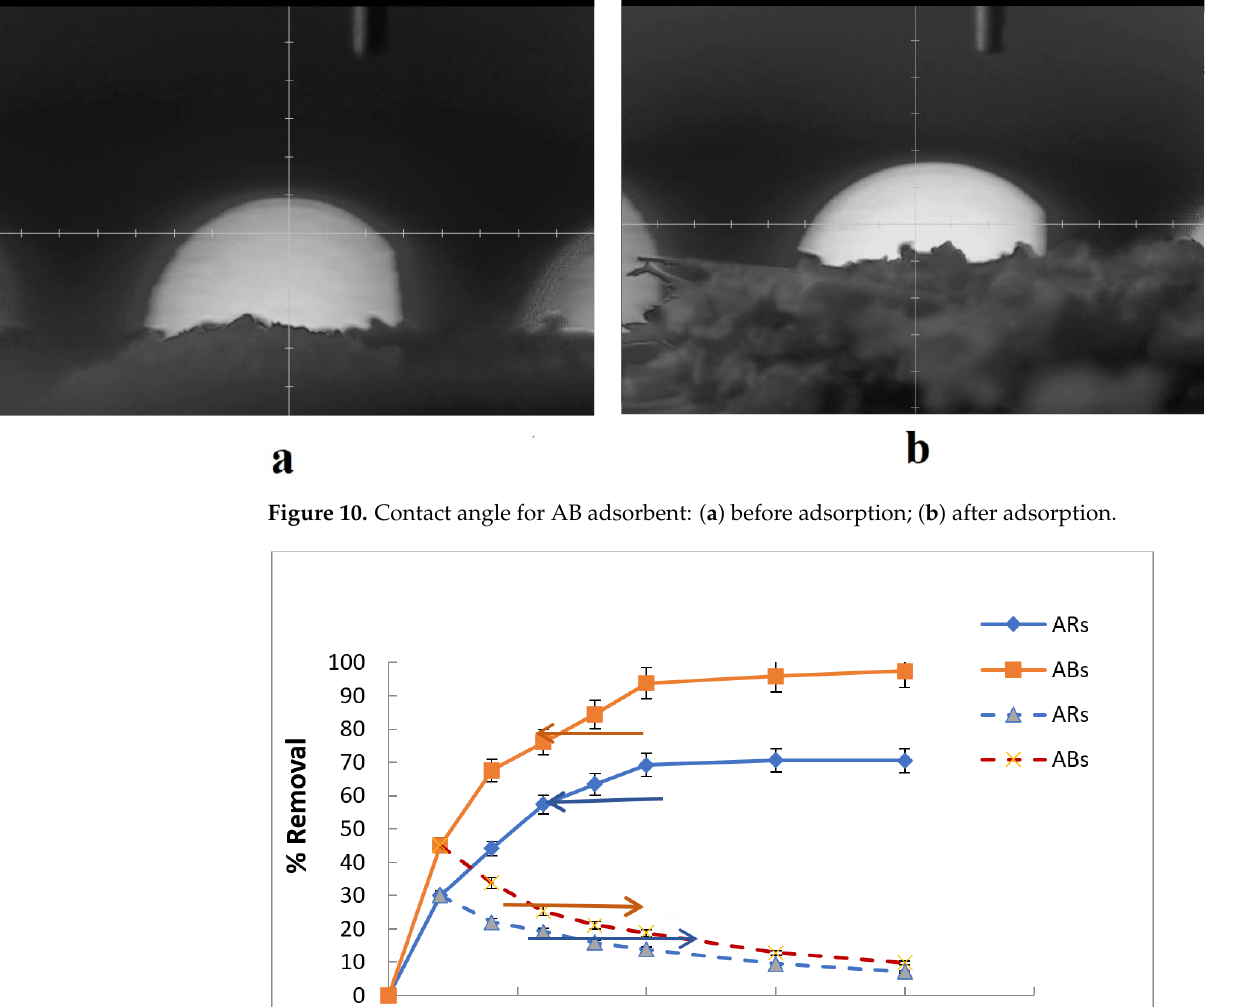
Figure 9. Contact angle for AR adsorbent: ( a ) before adsorption; ( b ) after adsorption.